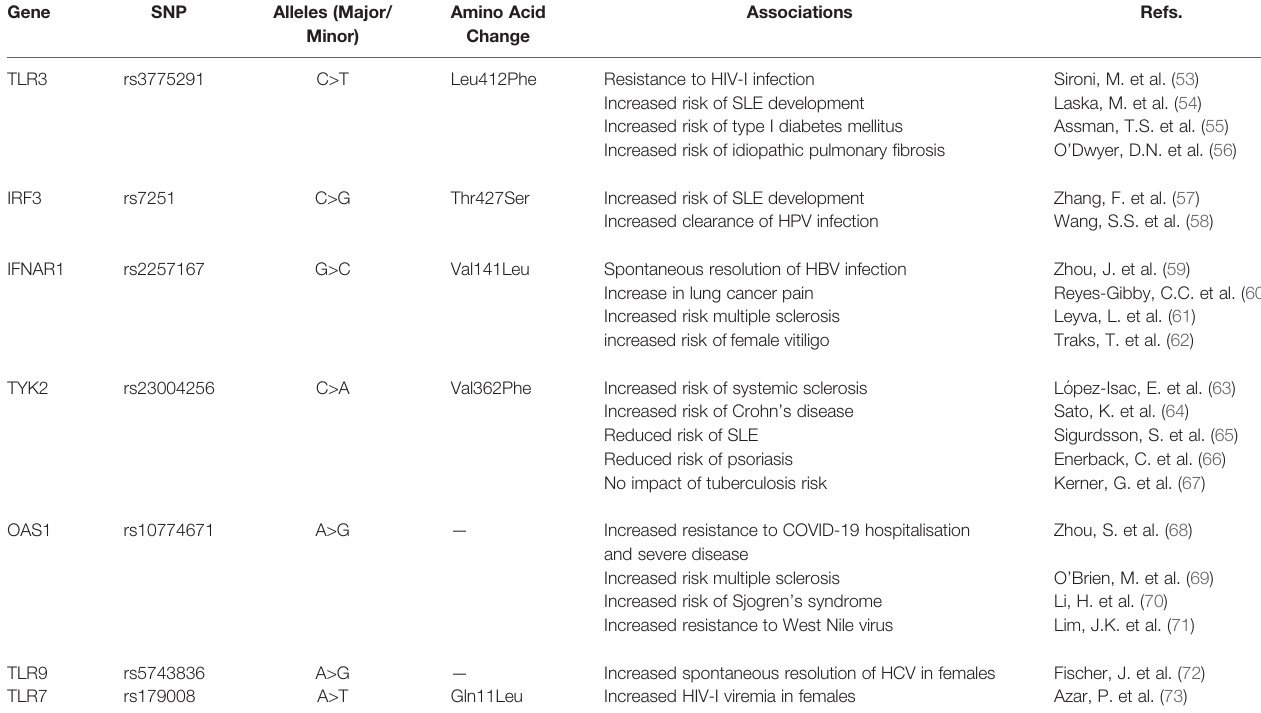
TABLE 1 | List of selected SNPs in the type I interferon